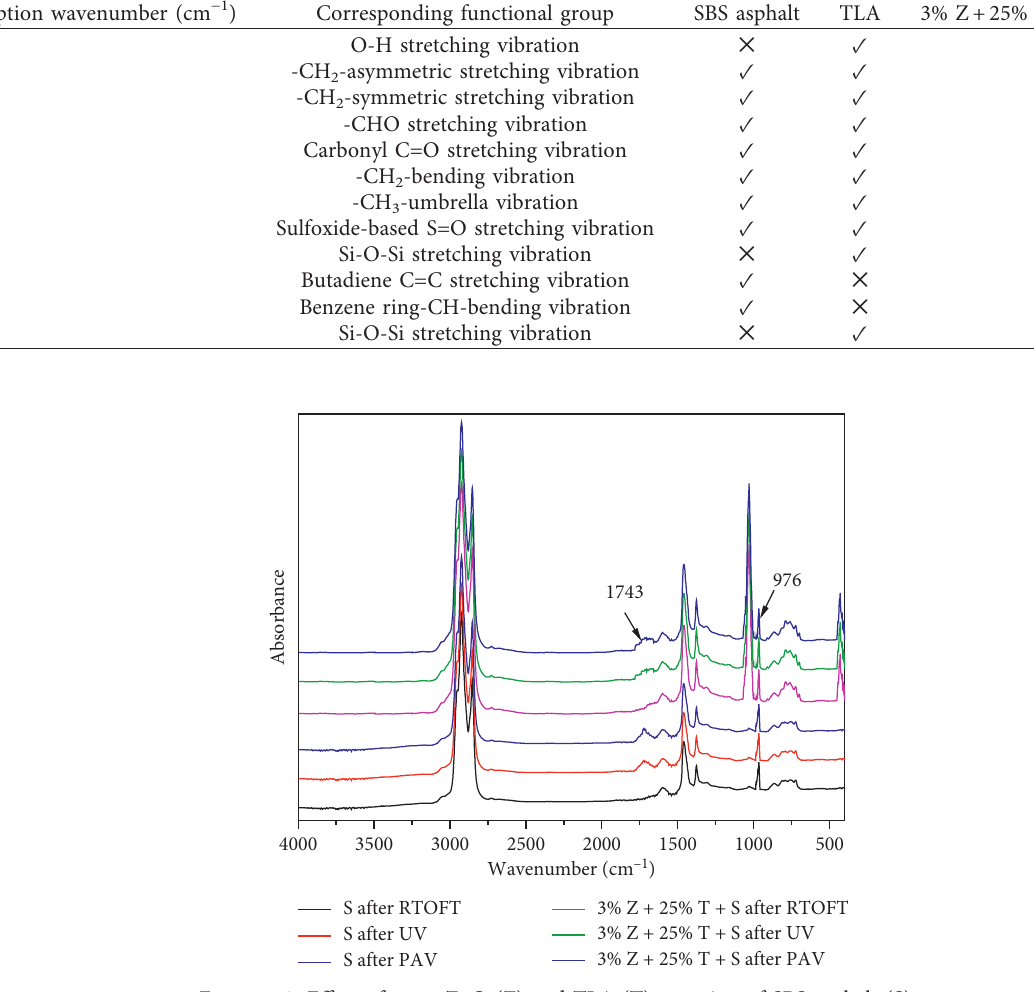
Figure 10: Effect of nano-ZnO (Z) and TLA (T) on aging of SBS asphalt